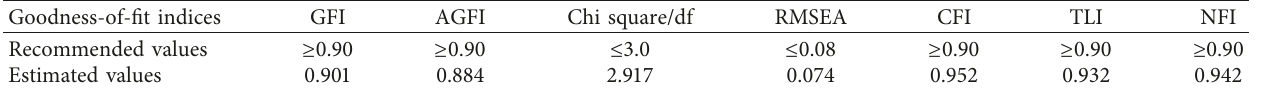
Table 2: Goodness-of-fit indices.